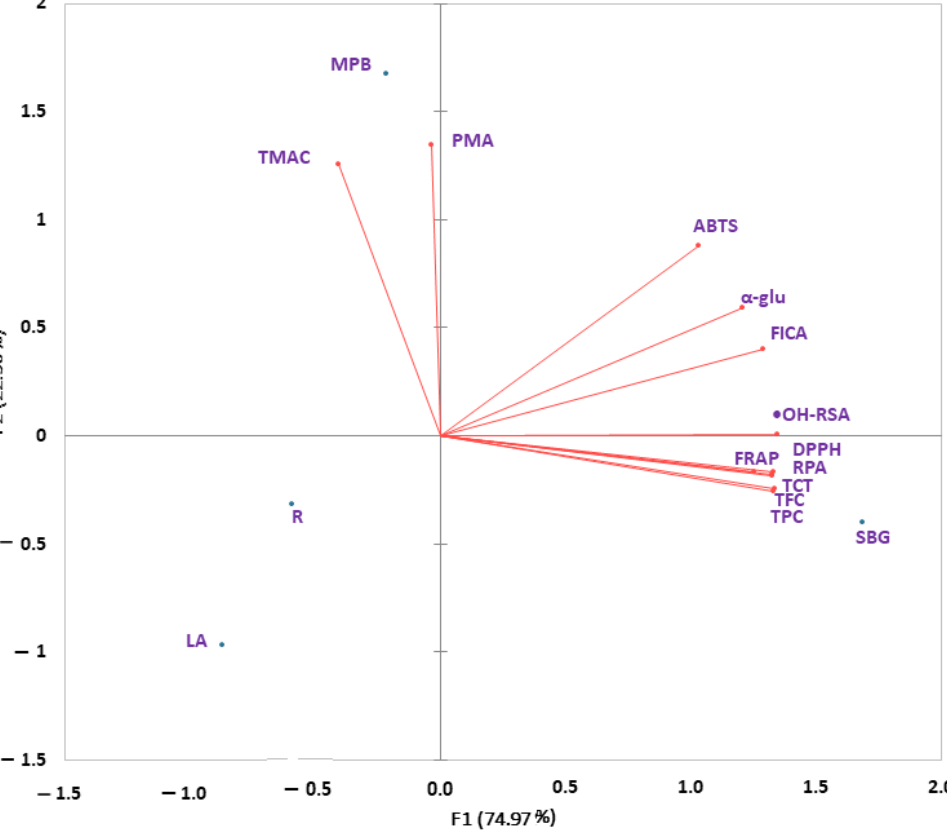
Figure 2. Biplot analysis of phenolic contents and biological activities in native Australian lemon aspen ( LA ), rosella (R), strawberry gum ( SBG ), and mountain pepper berries ( MPB ). Benzoic acid and Its Derivatives Benzoic acid is the simplest aromatic carboxylic acid and has a range of derivatives. Eight hydroxybenzoic acids in total were tentatively identified in these native Australian plants. Compounds 1 , 3 , and 8 produced fragment ions at m / z 169, 153, and 137 after pounds 1 , 3 , and 8 were tentatively identified as gallic acid 4- O -glucoside, protocatechuic acid 4- O -glucoside, and 4-hydroxybenzoic acid 4- O -glucoside, respectively. Compounds 2 ,